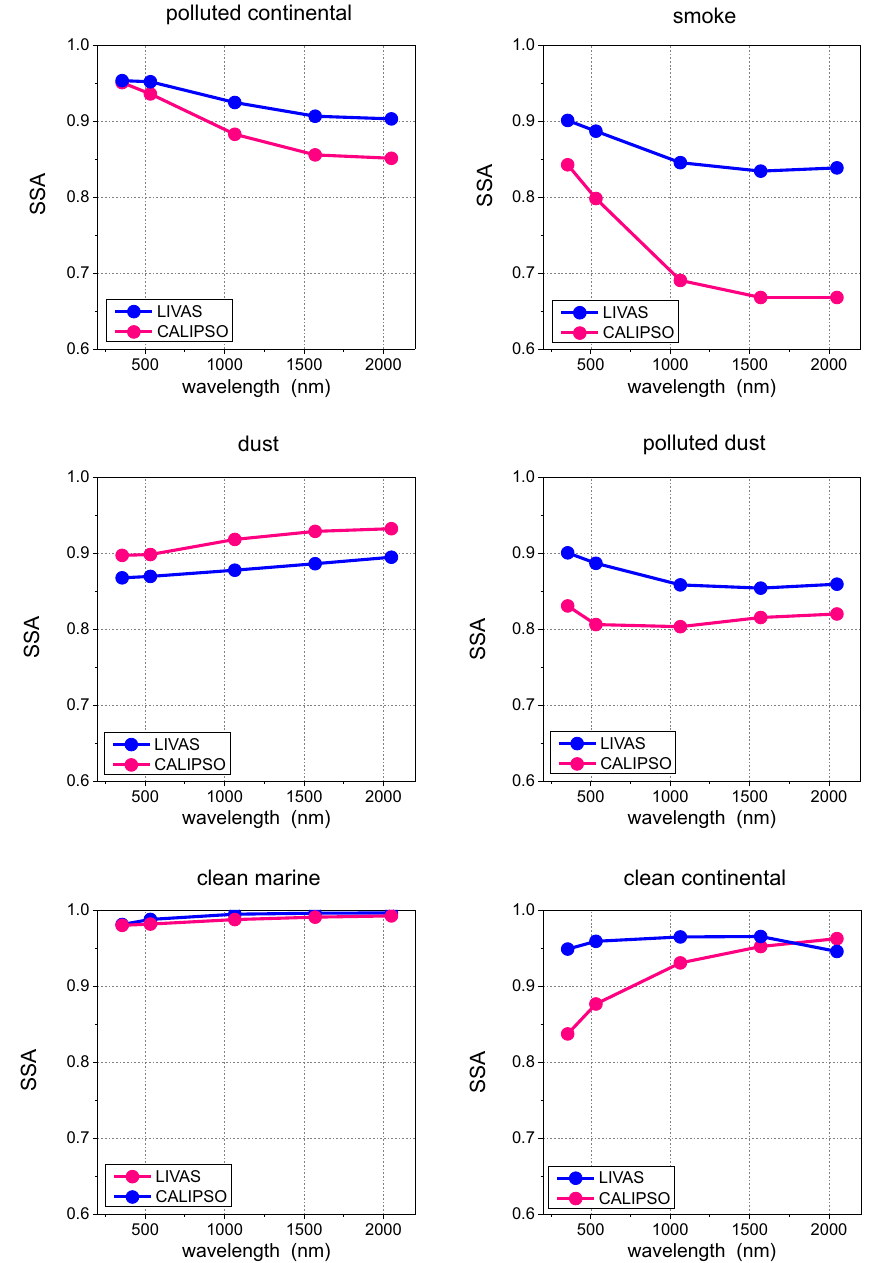
Figure 6. Comparison of the mean spectral SSA for each aerosol type in the LIVAS (blue line) and CALIPSO (pink line) aerosol